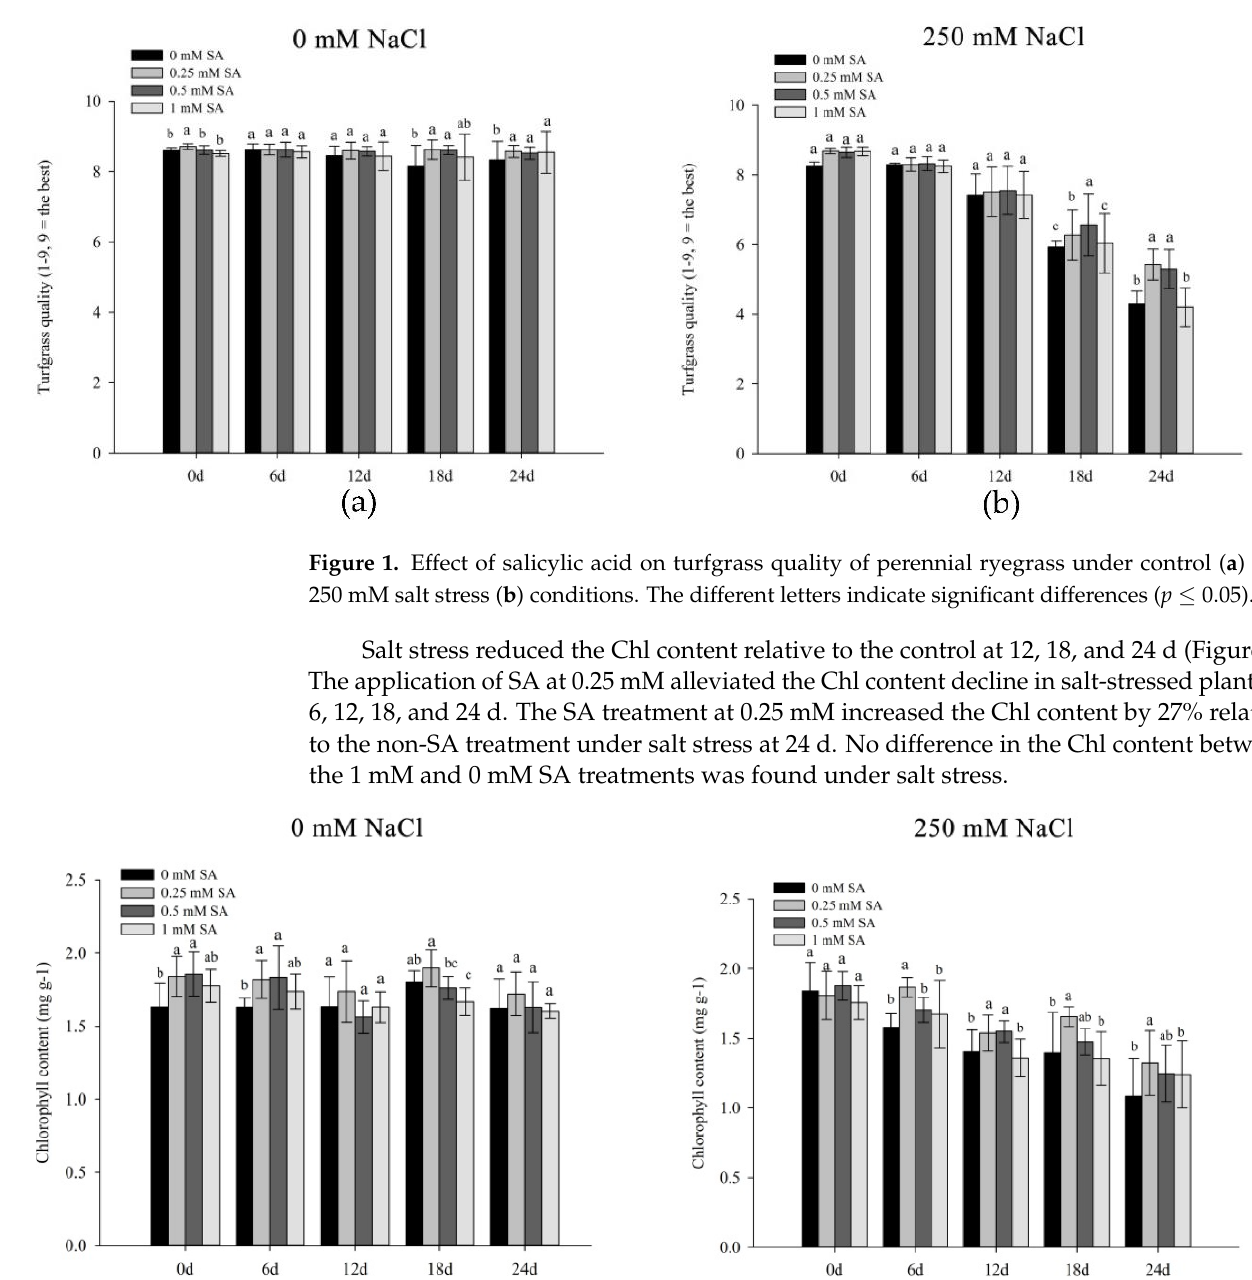
Figure 2. Effect of salicylic acid on chlorophyll content of perennial ryegrass under control ( a ) and 250 mM salt stress ( b ) conditions. The different letters indicate significant differences ( p ≤ 0.05) .